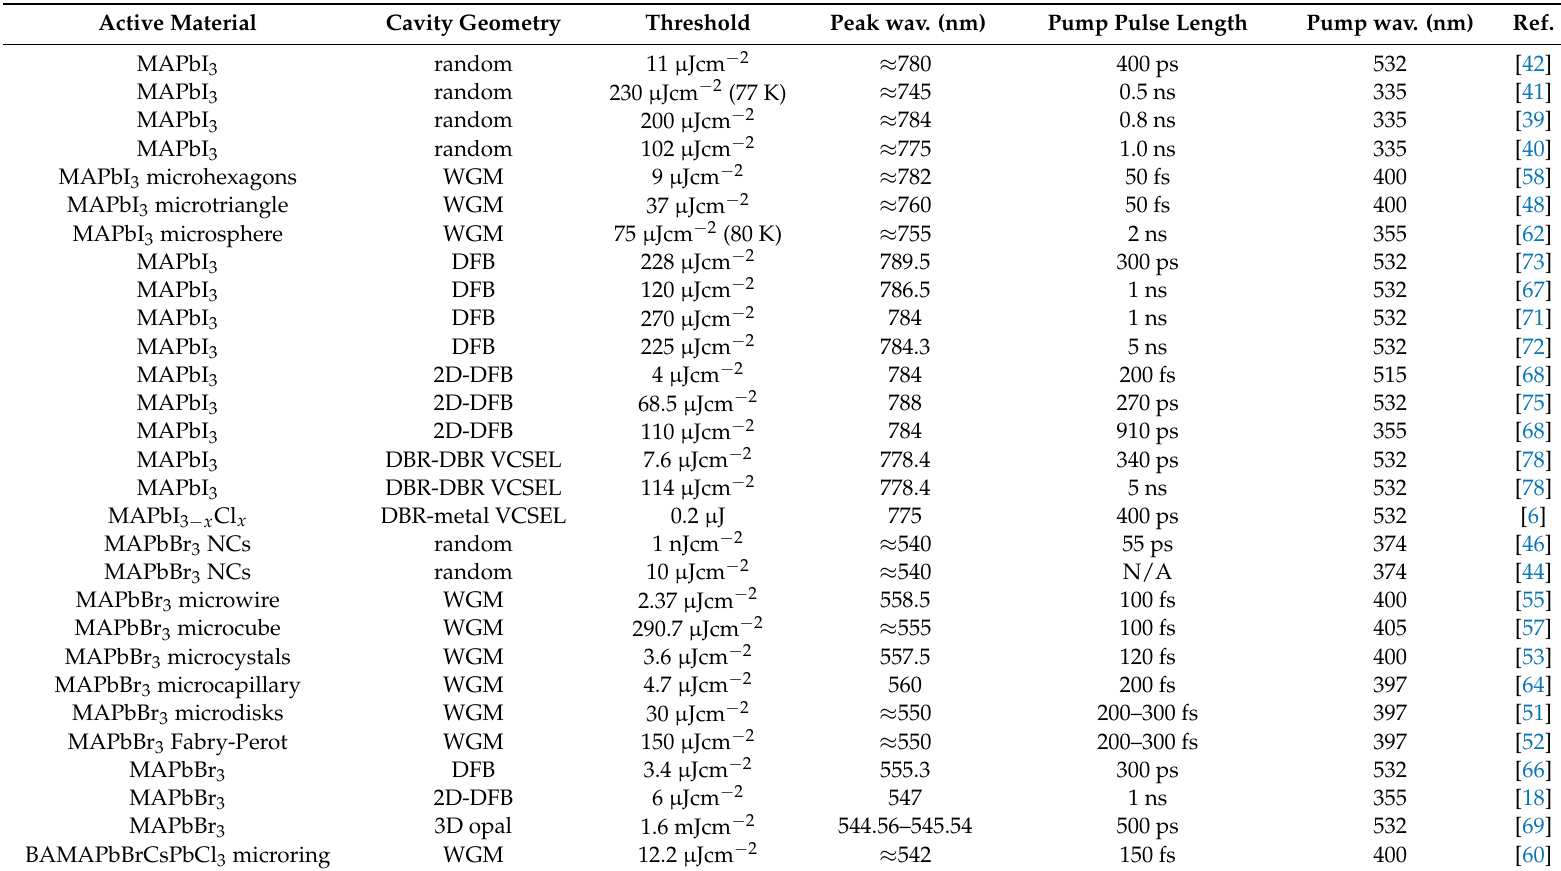
Table 2. Lasing properties of the perovskite lasers described in this review. The data are grouped taking into account the active material and then the cavity type, and are in order of increasing pump pulse time width. In papers discussing multiple devices the reported data are relative to the device with the minimum threshold. N/A evidences non available